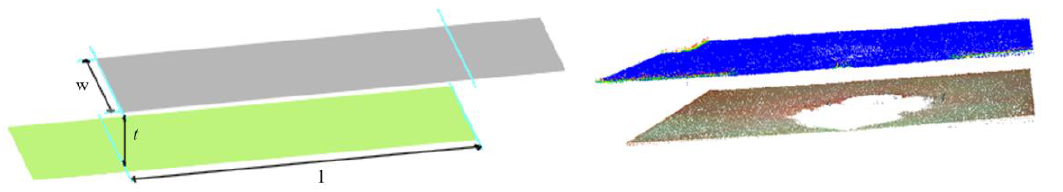
Figure 8. Alignment and overlap of a pair of parallel planar patches.